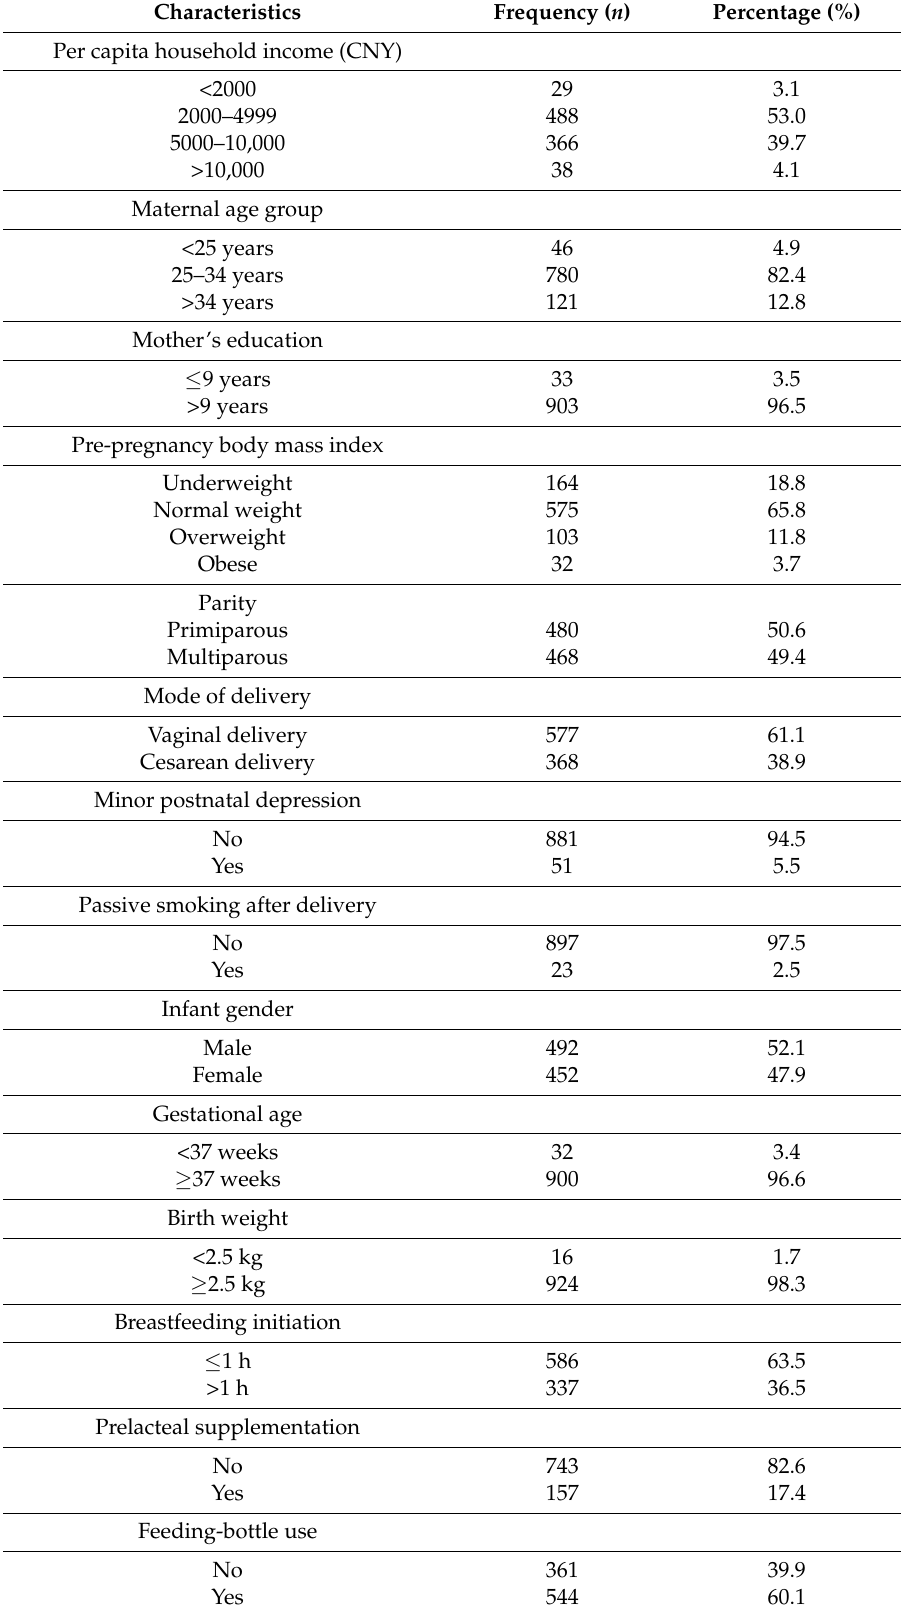
Table 1. General characteristics of 951 mother-infant